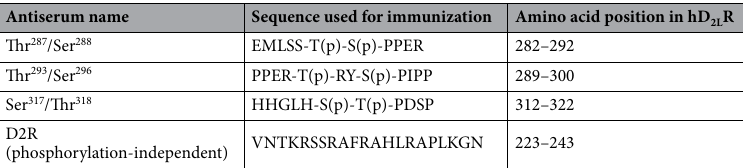
Table 1. D 2 R peptide sequences used for generation of phosphosite-specific antisera. List of peptide sequences used for generating phosphosite-specific antibodies against individual phosphorylated forms of the D 2 R and